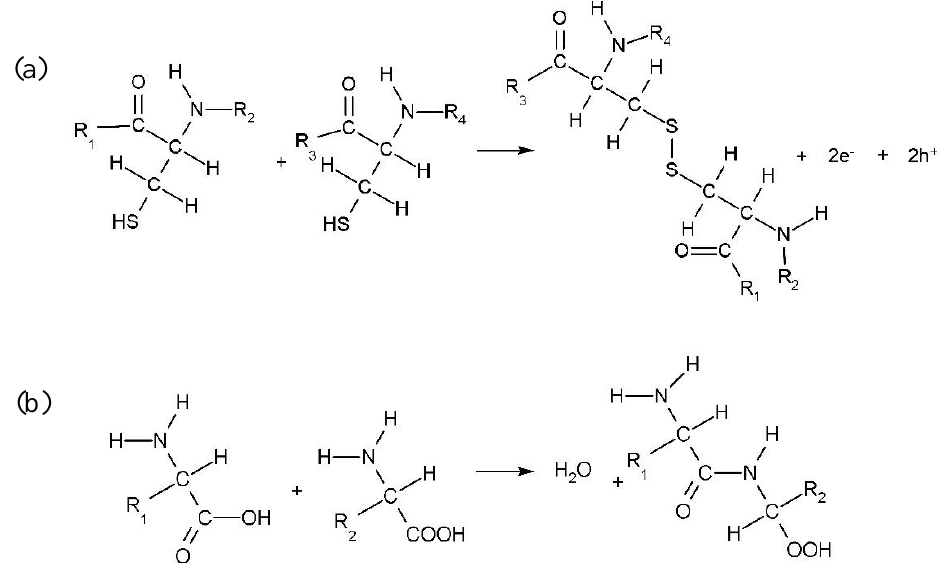
Figure 15. ( a ) Peptide bond and ( b ) disulphide bond generation process.